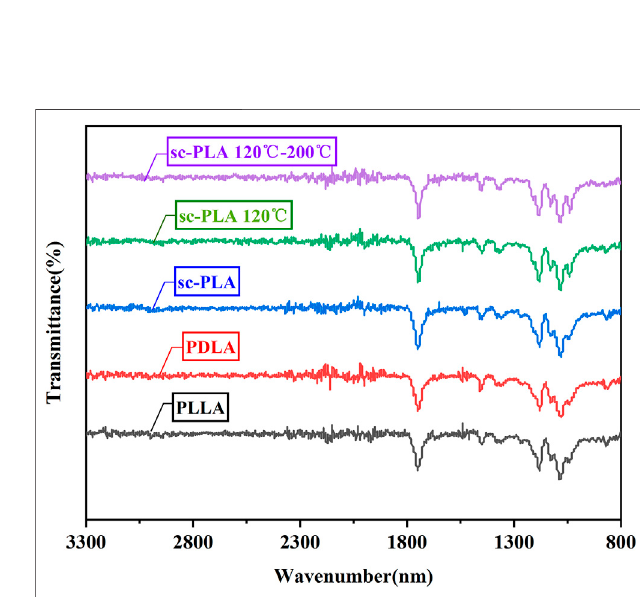
FIGURE 2 | DSC curves of electrospun fi bers of PLLA, PDLA, sc-PLA, sc-PLA 120 ° C, and sc-PLA 120 – 200 ° C.